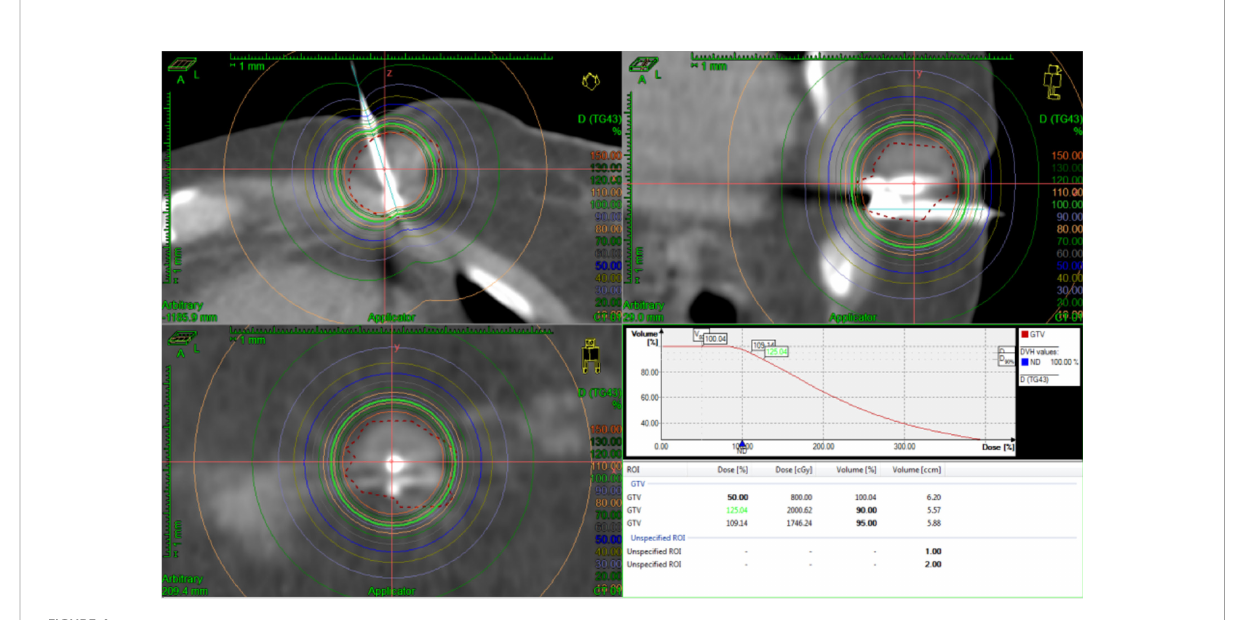
FIGURE 4 Three-dimensional dose distribution and DVH of the fi rst fraction of